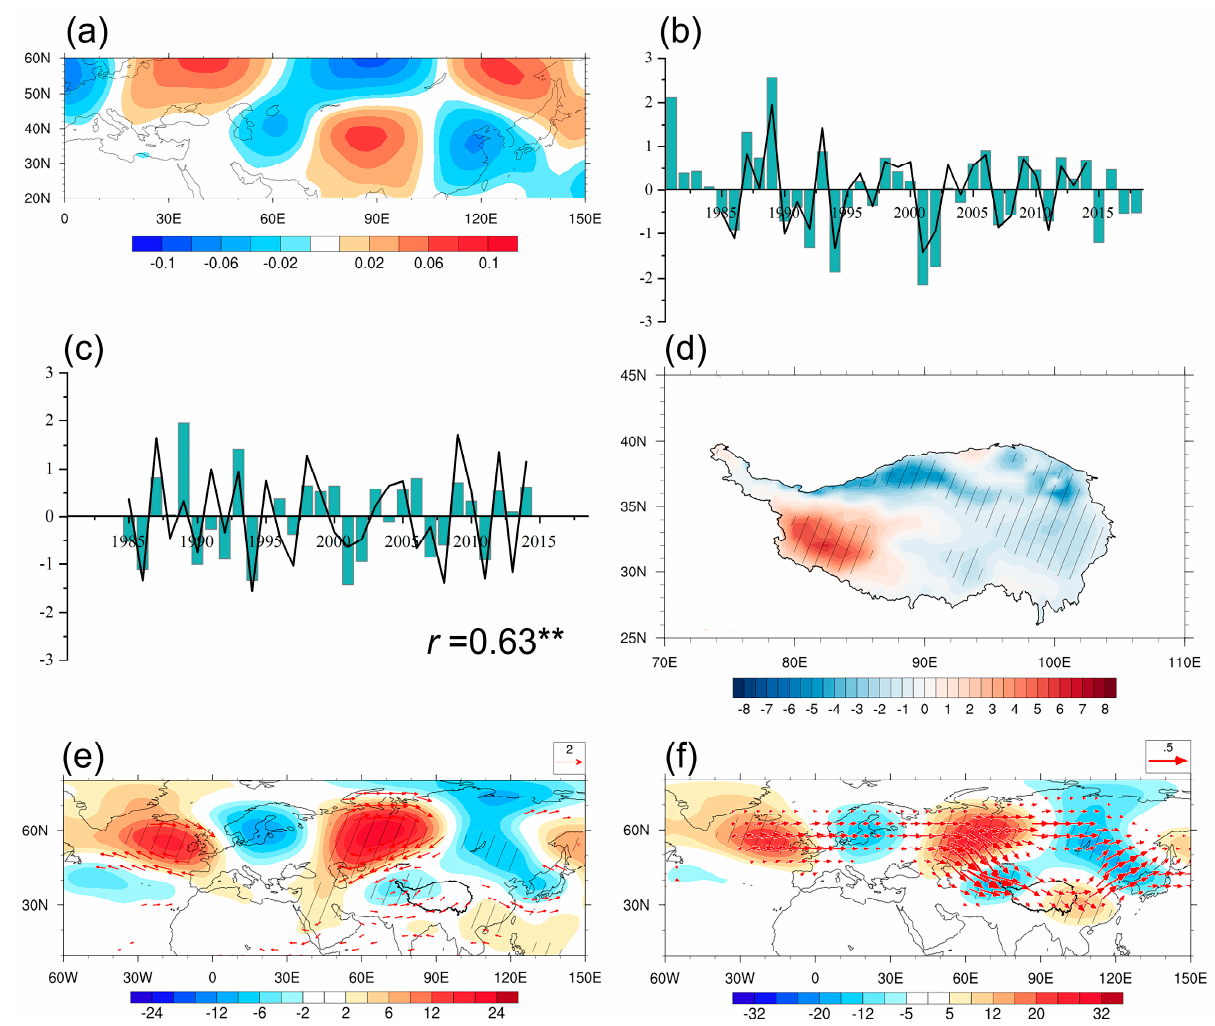
Figure 12. ( a ) The second EOF of summer mean 200 hPa meridional wind in 20–60 ◦ N, 0–150 ◦ E for the period 1981–2018. ( b ) Normalized time series of NAENA index (column) and its interannual component (line). ( c ) Normalized time series of interannual components of NAENAI (column) and PC2-IA (line), (**: significant at 99% confidience level). Anomalies in the interannual component of sensible heating ( d ), 500 hPa geopotential height (shading, gpm) and the wind exceeding the 95% confidence level (vector, m/s) ( e ), the 200 hPa geopotential height (shading, gpm), and the wave activity flux (vector, m 2 s − 2 ) ( f ) regressed on PC2-IA. Grid points with statistically significant anomalies passing the 95% confidence level are denoted by oblique lines.